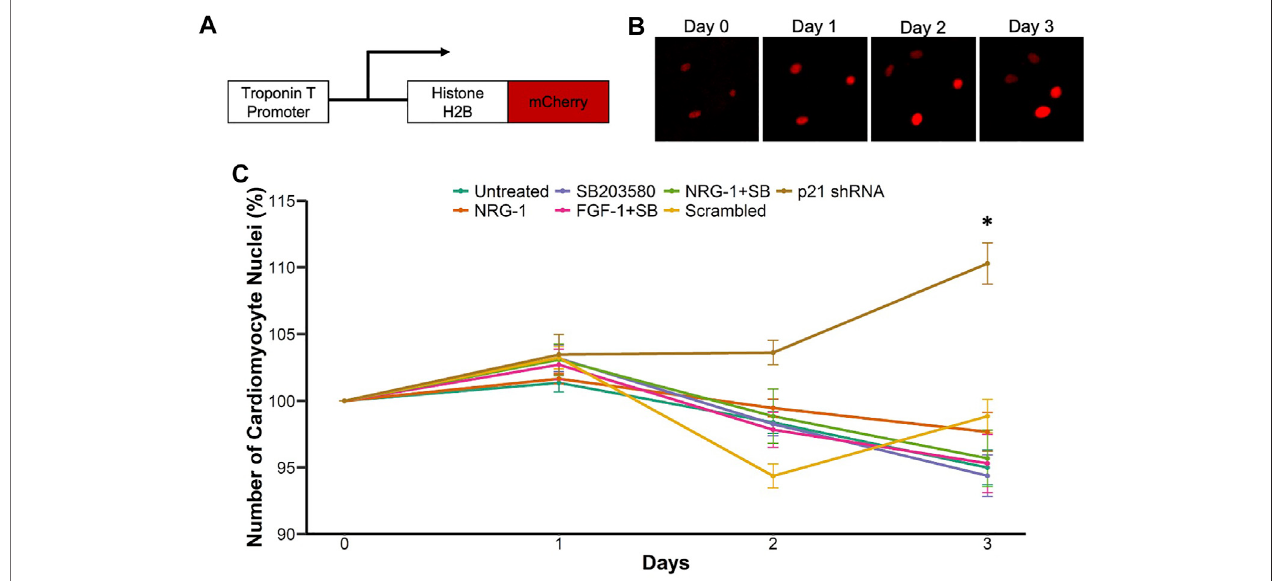
FIGURE 2 | Live-cell imaging platform to quantify cardiomyocyte proliferation. (A) Schematic representation of Troponin T promoter driven Histone H2B-mCherry expressing adenovirus (B) Example of cardiomyocyte nuclear division (C) Live cell imaging mediated measurement of cardiomyocyte mitosis. Cell growth percentage is measured as number of cardiomyocyte nuclei at days 1 – 3 relative to day 0. *** p < 0.001 vs respective control, n = 12 for each group.